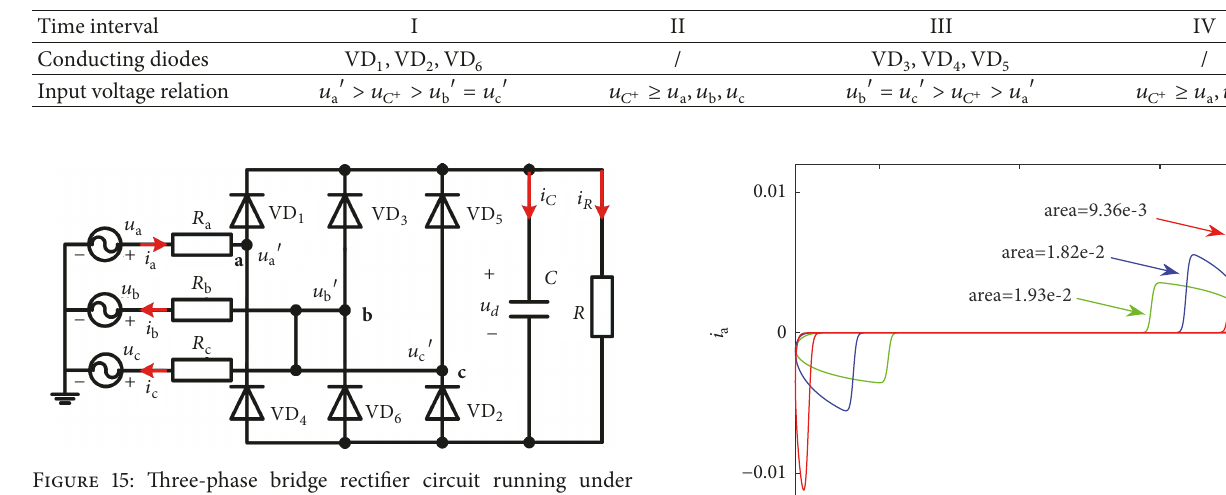
Table 5: Conduction situations of six diodes.